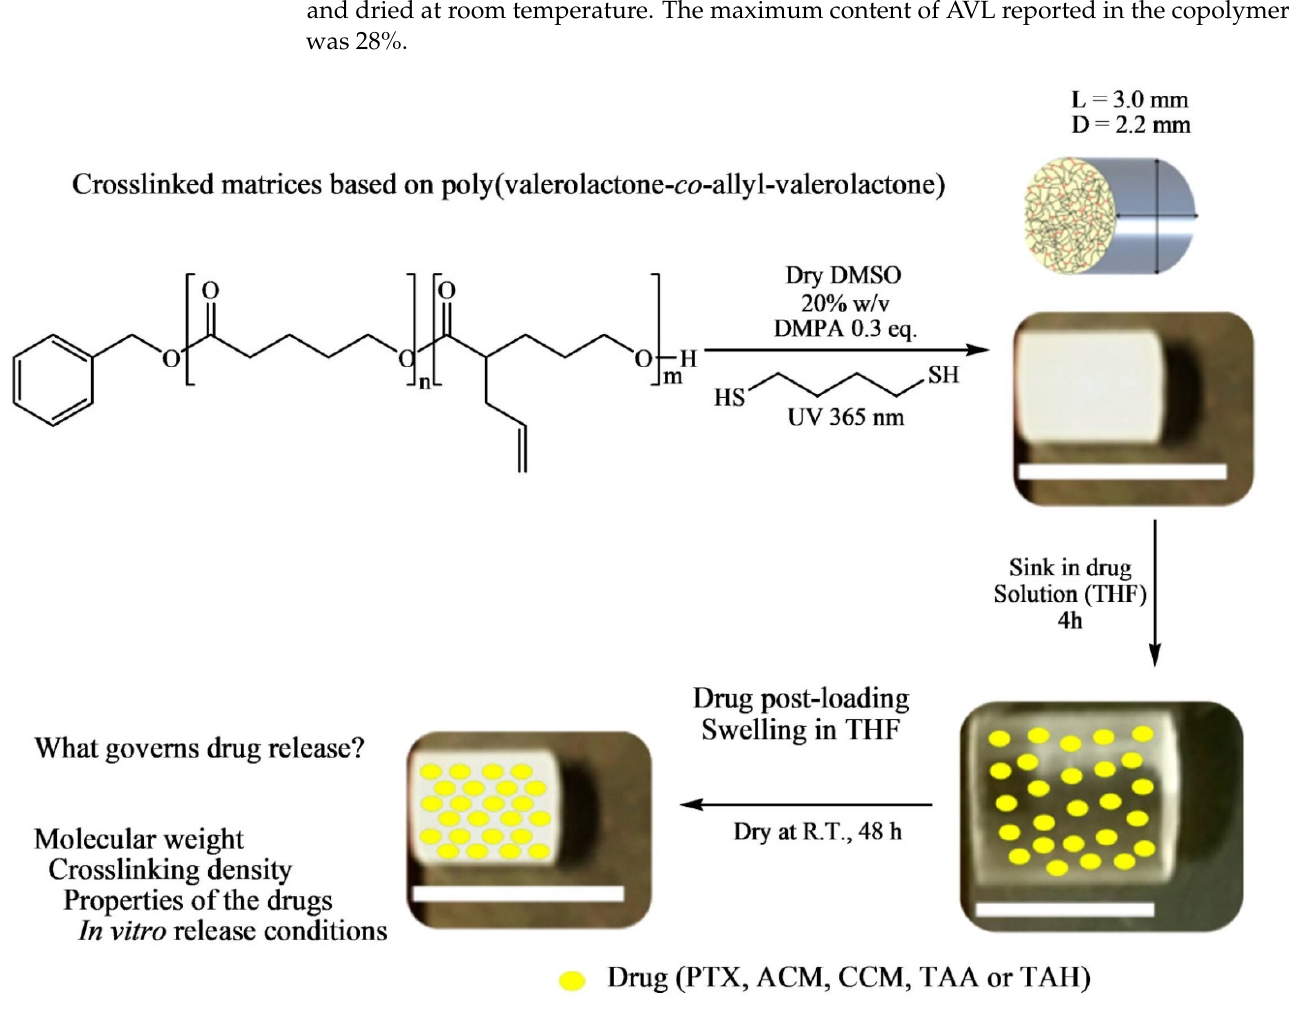
Figure 7. Schematic of the formation of the crosslinked polymer network and post-drug loading procedure in organic solvent of the IDDS as designed by Le Devedec et al. Adapted with permission from [60]; published by American Chemical Society, 2018.